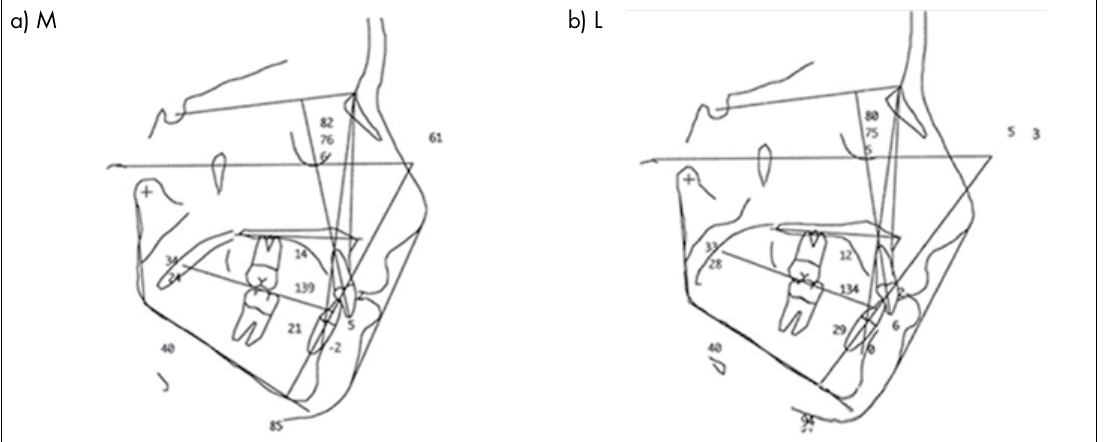
Figure 6. Pretreatment lateral cephalometric